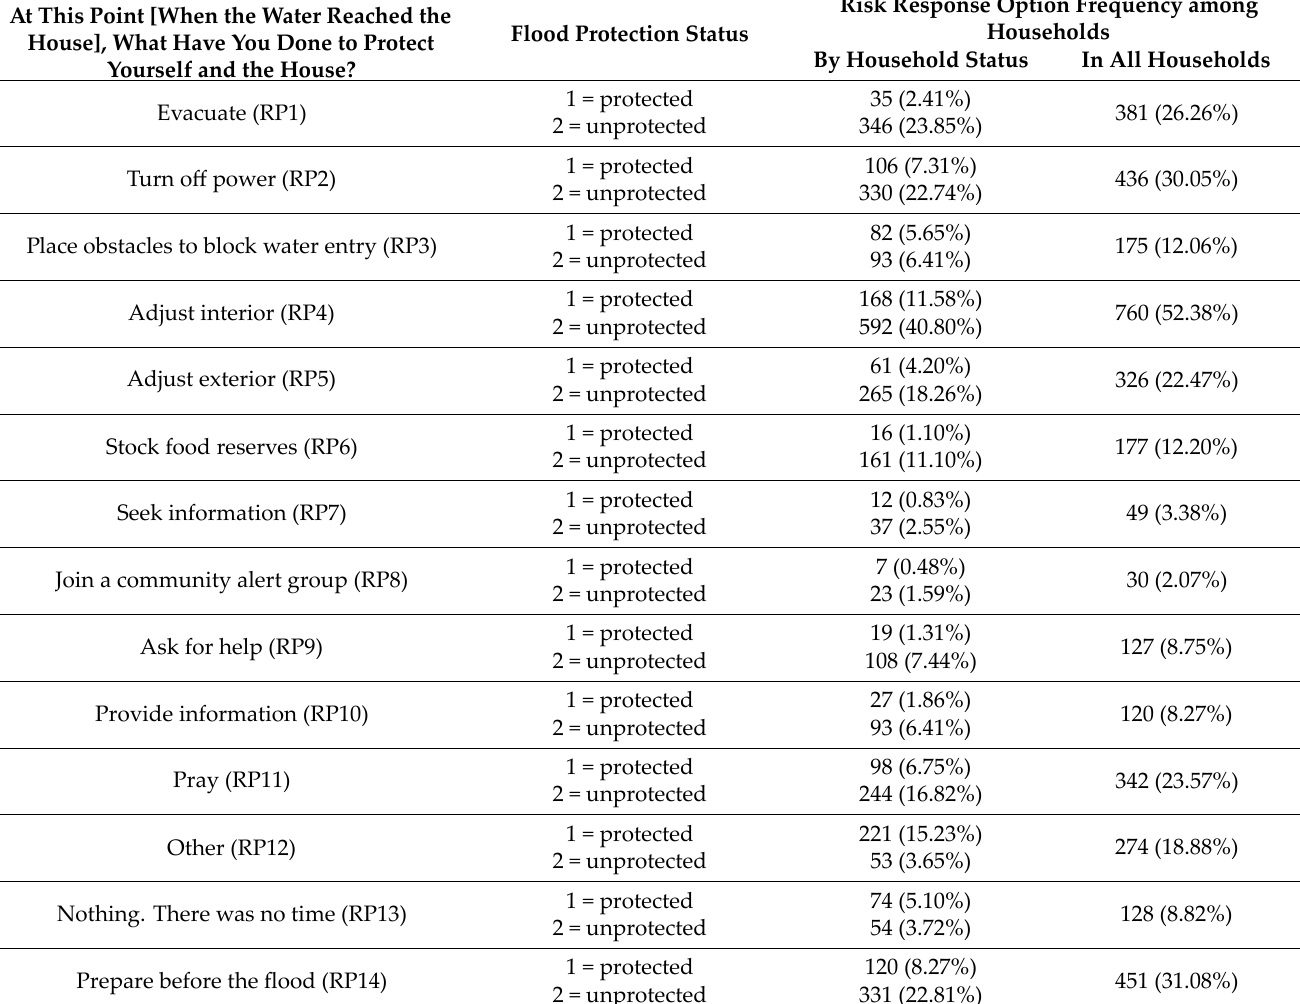
Table 4. Bivariate analysis of risk response options against household